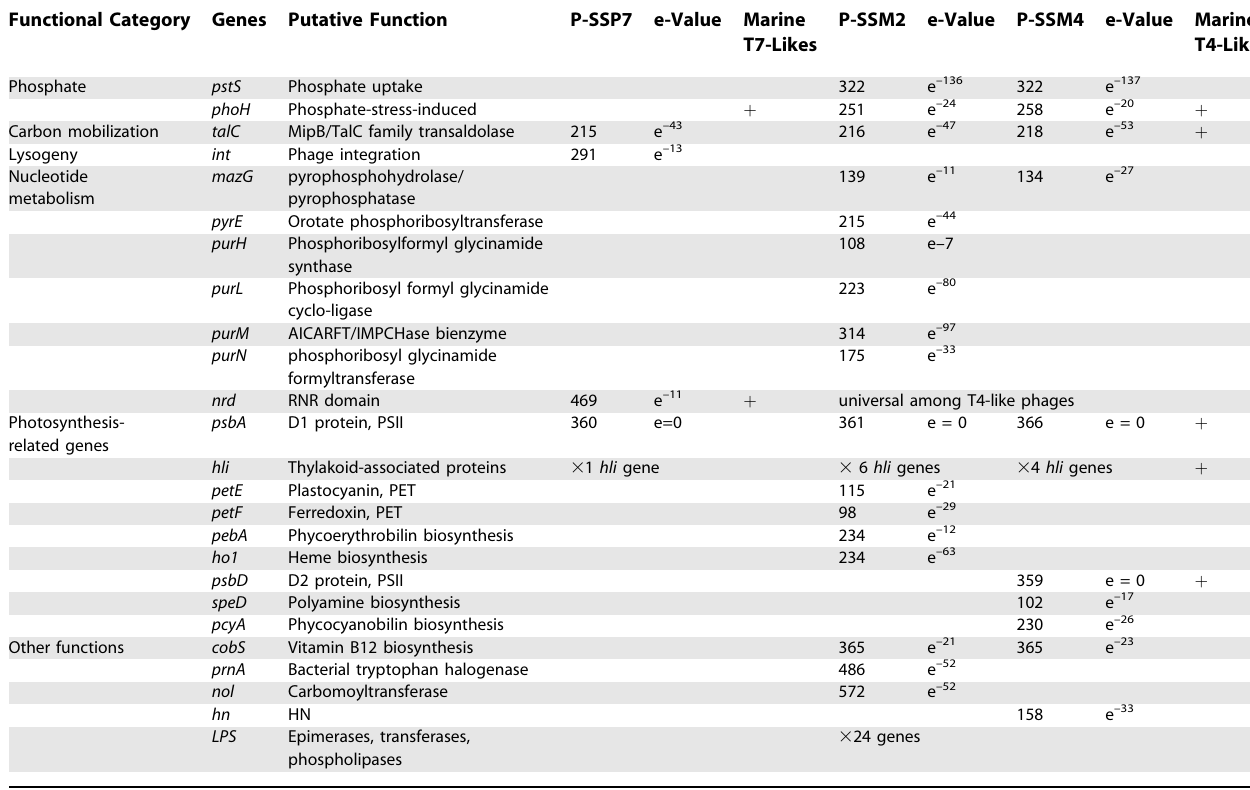
Table 5. Summary Table of Unique Features of Prochlorococcus Cyanophage Genomes That Are Uncommon among Known Phages Functional Category Genes Putative